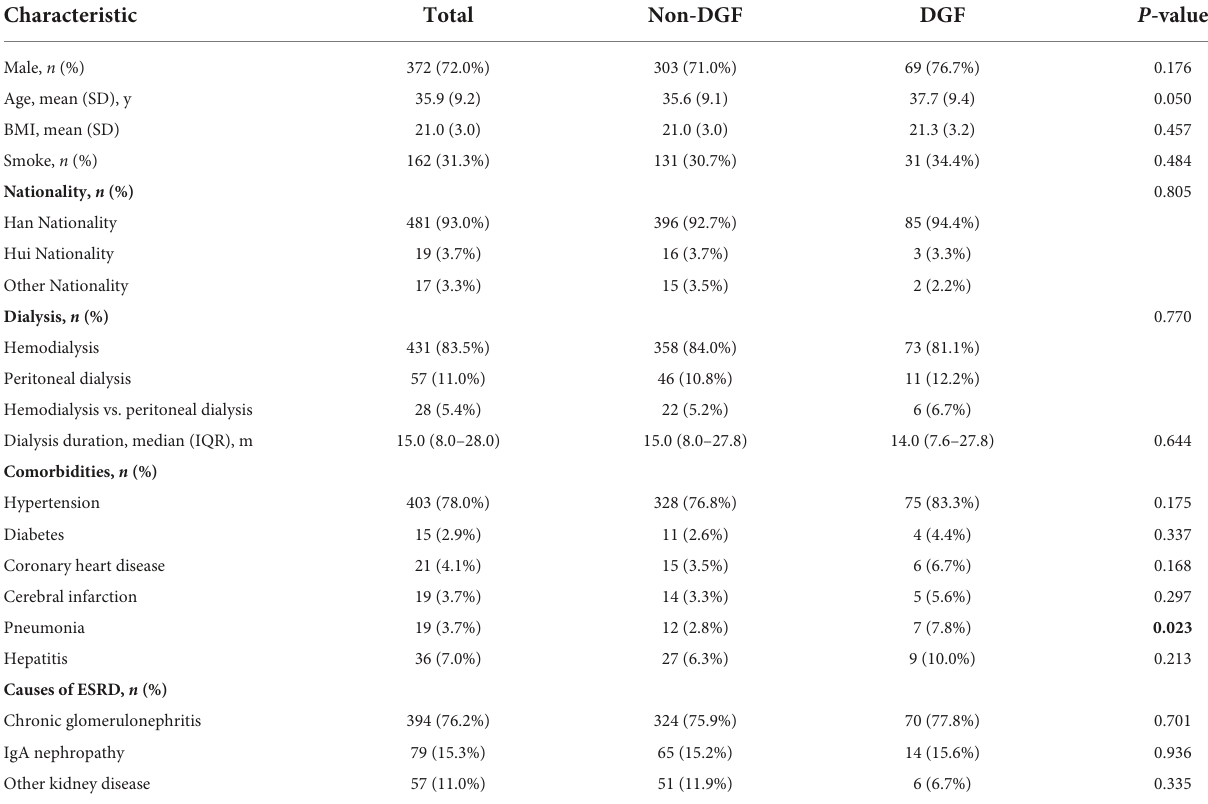
TABLE 1 Demographics and clinical characteristics among patients in the development cohort who did or did not develop